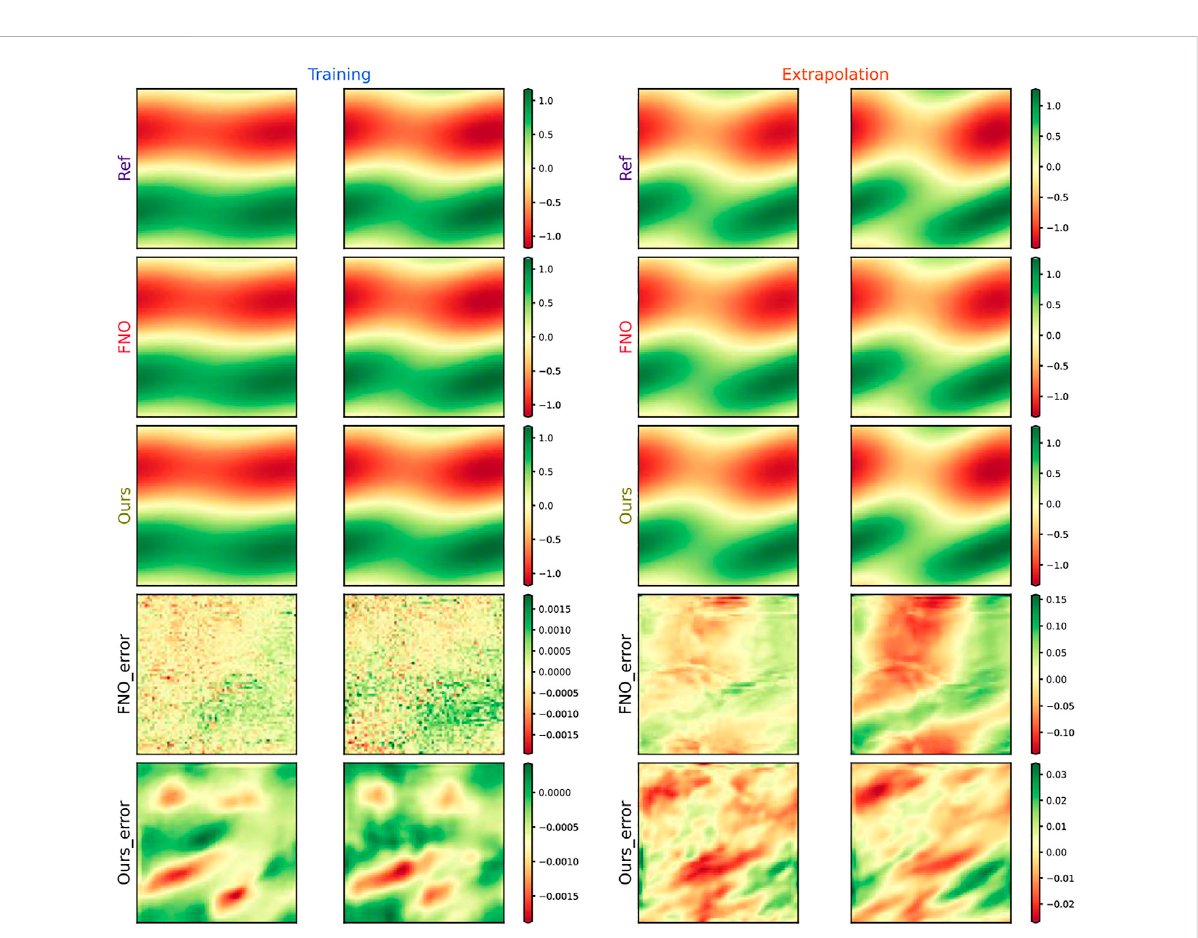
FIGURE 5 VorticityresultsofPA_CasualLSTM-solved 2DNavier – Stokesequation,andfourrepresentativemomentsareselectedforcomparison,namely, training ( t = 1, 1.7s) and extrapolation ( t = 2.5, 3.5s), and the errors across the entire interval are compared. The sub fi gures from top to bottom are reference solutions, predictions by FNO and PA_CasualLSTM, and errors of FNO and PA_CasualLSTM,